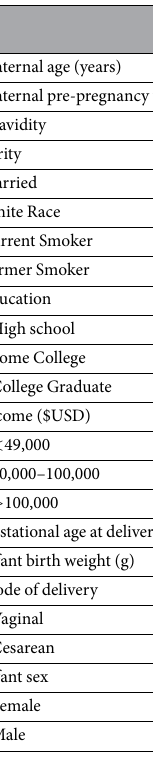
Table 1. Subject characteristics and birth outcomes (n =